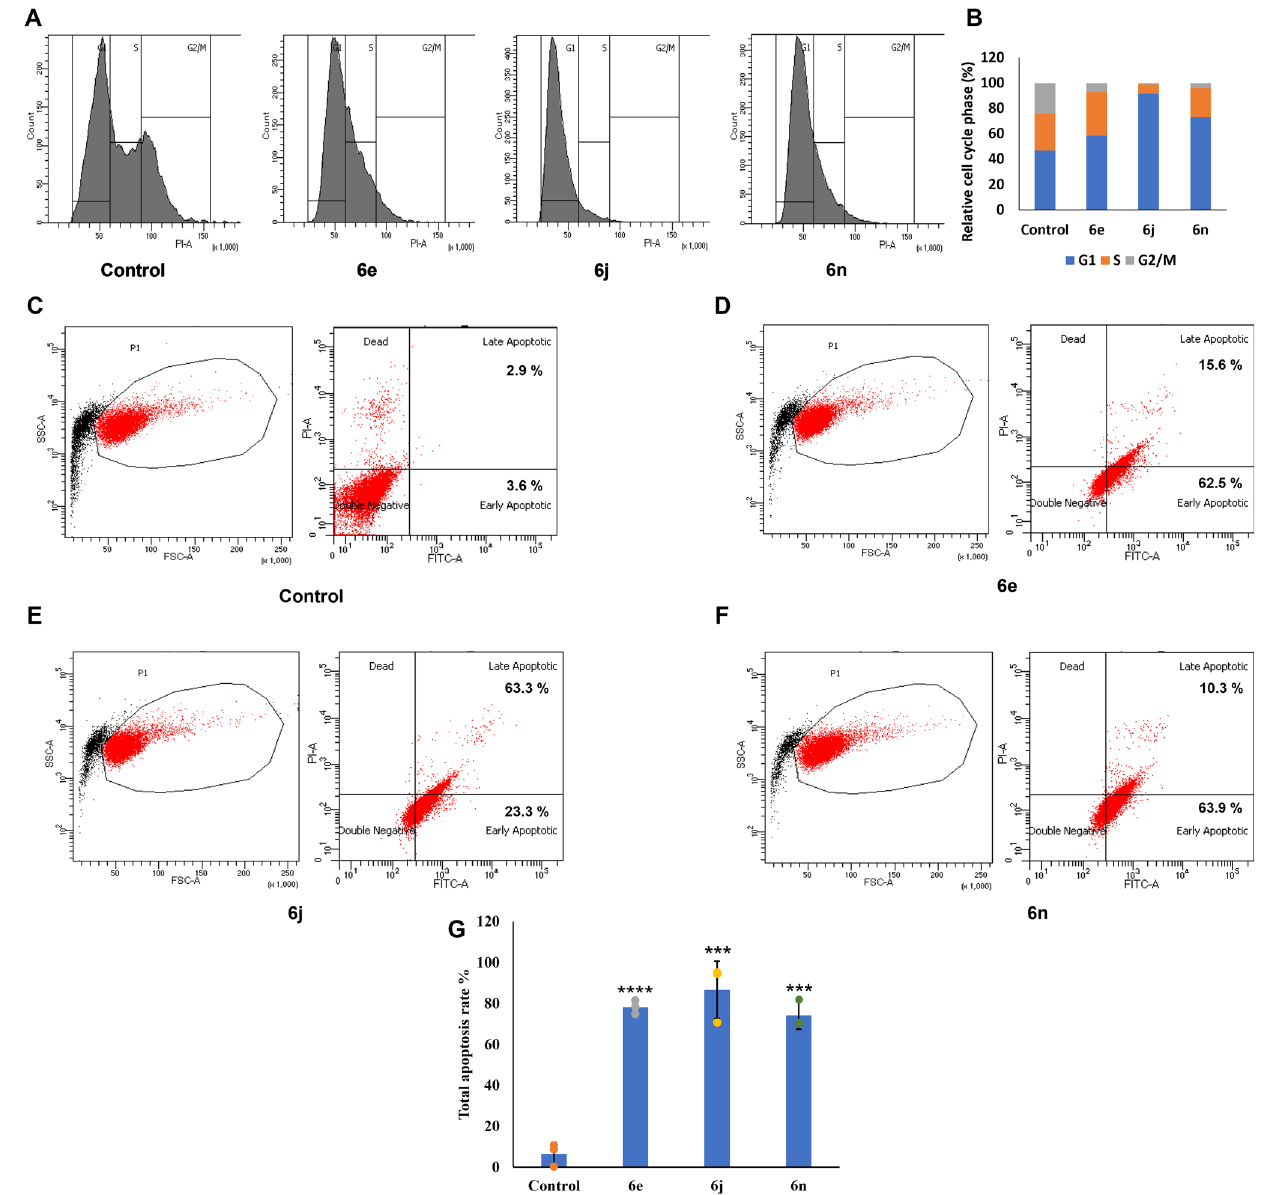
Fig. 7 Flow cytometric analysis of cell cycle and apoptosis in cells treated with cATC derivatives. HeLa cells were treated with 6e , 6j, and 6n for 18 h. A – B The cell cycle was evaluated by fl ow cytometry after staining with propidium iodide (PI) for 30 min at 37 °C in dark. A Graphs show the cell count in different phases of cell cycle after treatment with 6e, 6j , and 6n and control. B Histogram shows % cell distribution of HeLa cells in different phases of cell cycle. C – G The cells were stained with FITC-conjugated Annexin V (AV) and Propidium Iodide (PI), and analyzed by fl ow cytometer. The scatter plots for cells unstained ( C ), treated with DMSO ( D ), treated with IC 50 concentrations of 6e , 6j and 6n ( D , E , and F , respectively). The early apoptotic cells (FITC- AV + ve /PI -ve ) are shown in lower right quadrant. The late apoptotic cells (FITC-AV + ve /PI + ve ) are shown in upper right quadrant. G Bar graph shows total population of apoptotic cells in various samples. N = 3, mean ± SD; two-tailed unpaired Student ’ s t test was used for calculating P values; ns represents non-signi fi cant, * represents p -value ≤ 0.05, ** represents p -value ≤ 0.01, *** represents p -value ≤ 0.001 and, **** represents p -value ≤ 0.0001, N represents experiment